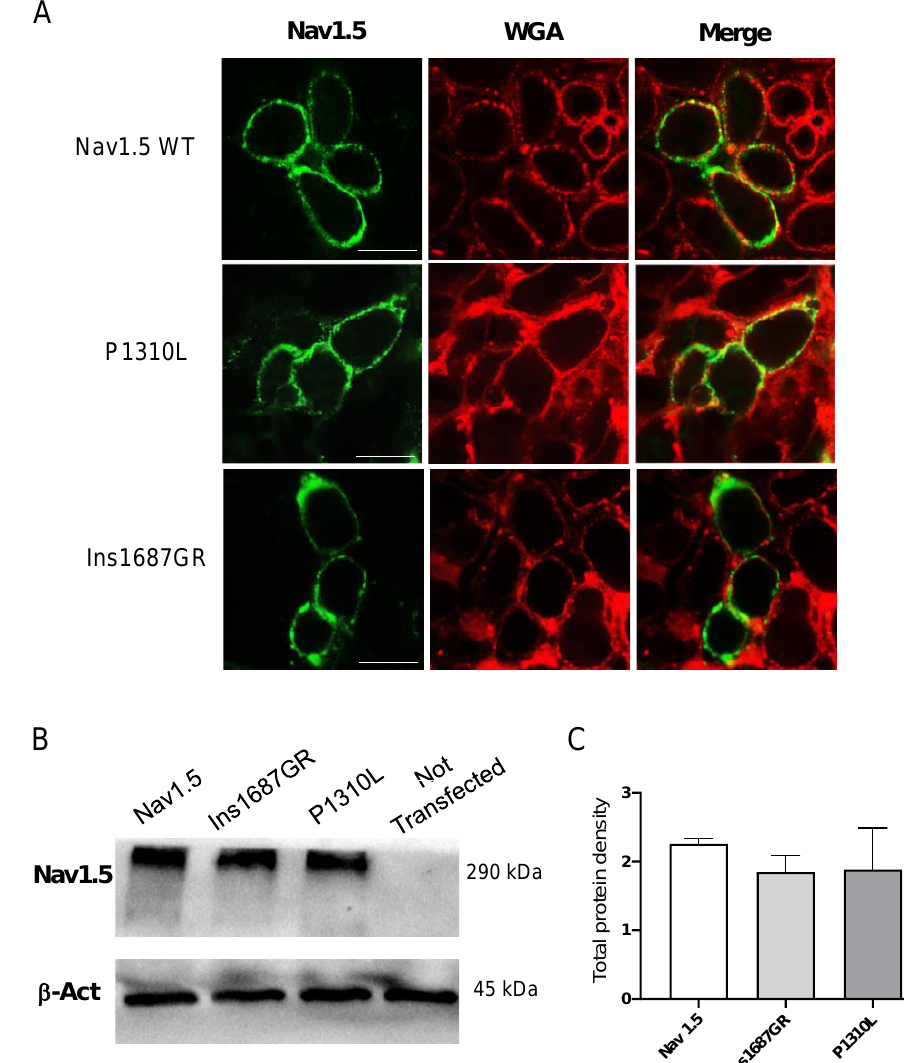
Figure 7. Plasma membrane localization of Nav1.5 WT, P1310L and Ins1687GR channels. ( A ) Immunofluorescence confocal microscopy analysis of the Nav1.5 WT, P1310L and Ins1687GR channels (green signal; left) and plasma membrane marker WGA-555 (red signal, middle) in HEK 293 cells grown on coverslips. The overlay column reports the co-localization of the two fluorescence signals (yellow, right). WGA, Wheat Germ Agglutinin. The horizontal bar indicates 10 µ m. ( B ) Immunoblotting analysis of Nav1.5 WT, Ins1687GR and P1310L channels expressed in HEK 293 cells. The position of molecular weight markers is at the right of the blots. Expressions of β -actin are displayed as controls for the loaded protein amounts. ( C ) Bar graph showing the total protein expression level for the indicated channel. For total protein expression, density was standardized as the ratio of the Nav1.5 signal to the cognate β -actin signal. Quantitative analysis was performed from 3 independent experiments.